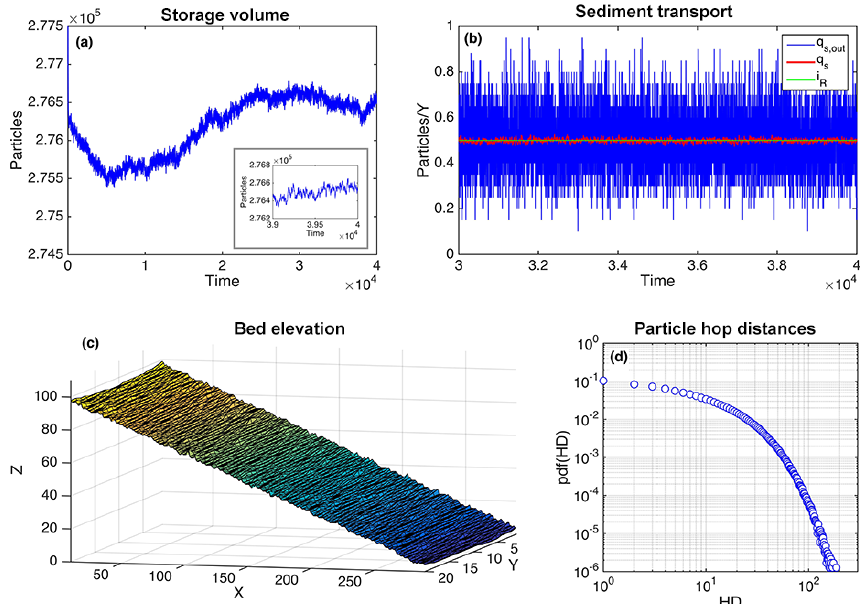
Figure 3. CAST RBM steady-state results of simulation with E = 1 . 5 and i R = 0 . 5. (a) Time series of storage volume: adjustment phases of aggradation and degradation around the equilibrium condition. In the inset a closeup of the last 1000 time steps is shown. (b) Time series of sediment transport: even with a constant input rate (green line) the sediment flux fluctuates. Fluctuations are large if measured in a single cross section at the downstream end (blue line) but become smaller if averaged over the entire control volume of the channel (red line). (c) Bed elevation in the final configuration: the model produces a rough bed with particles having different exposures R . (d) Probability density function of particle hop distances with an exponential distribution estimated over more than 2 million simulated particle paths.